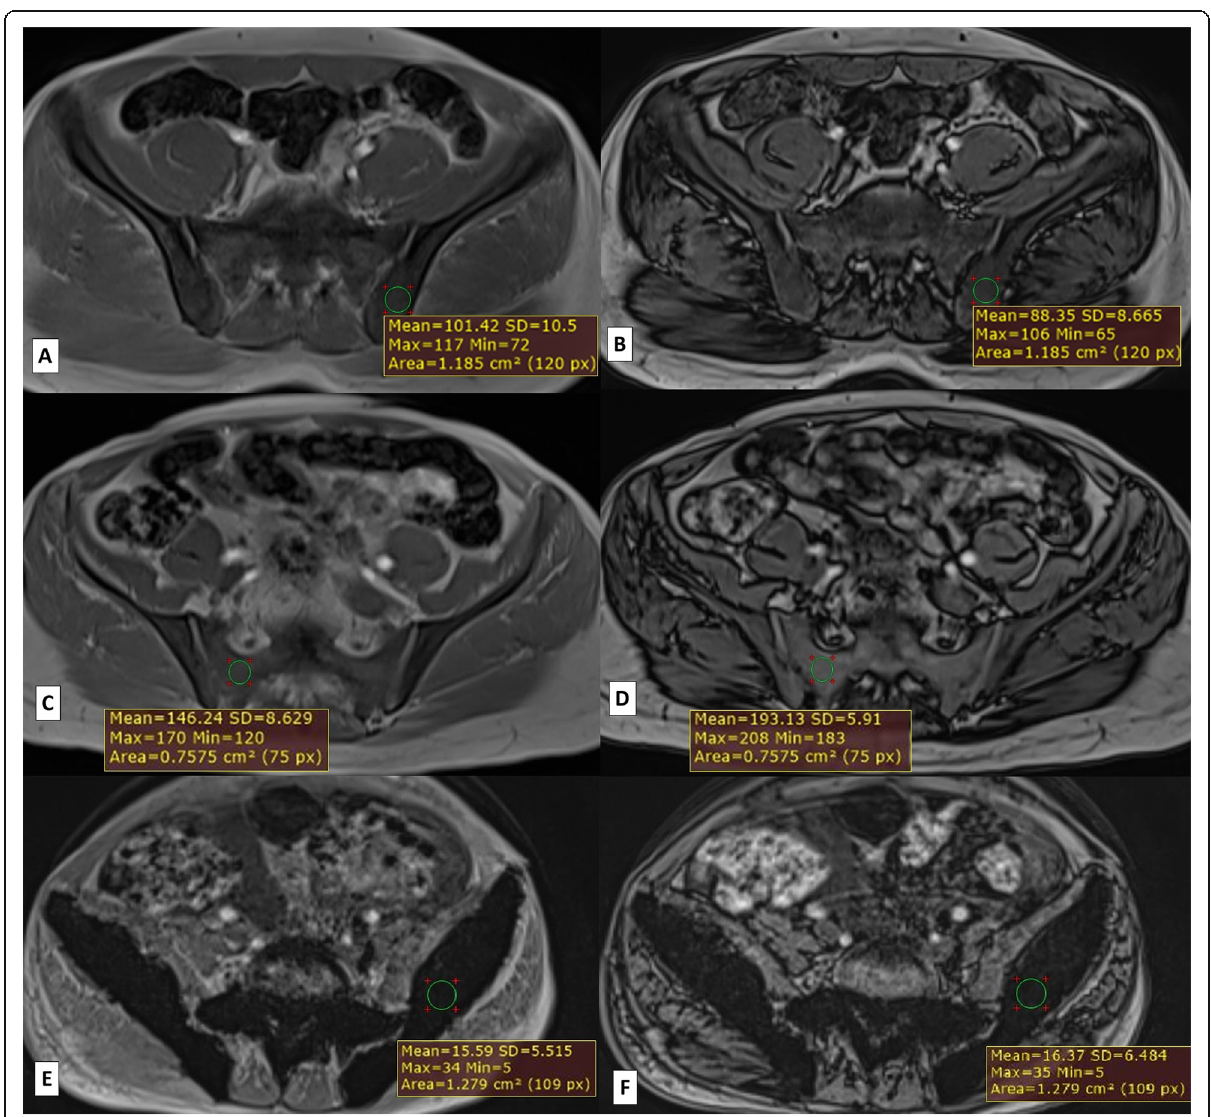
Fig. 1 Axial IP with corresponding OP images in three different patients with SCD and elevated serum ferritin; a and b show inadequate signal loss on OP images < 20%, (IP-OP/IP = 12%), c and d show lack of normal signal loss with reversal of normal signal characteristics of CSI in a different patient, OP > IP, (IP-OP/IP = − 32%), e and f show signal void pattern with diffuse very low signal on both IP and OP images